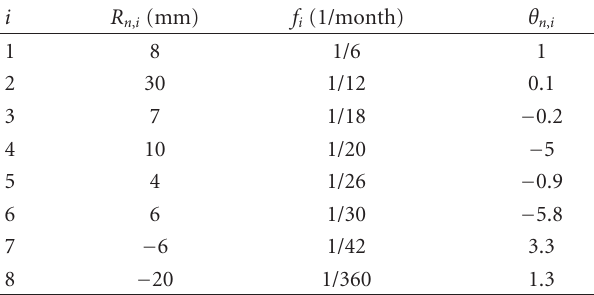
Figure 8: Correlogram up to lag 135 for series Z i . The dashed lines represent upper and lower bounds with significance level α = 0 . 05.